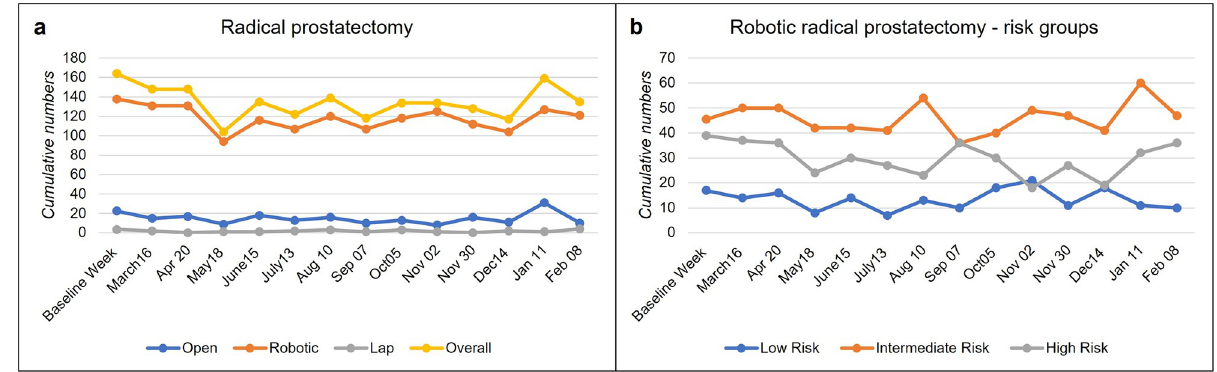
Fig 3. Changes in radical prostatectomies. (A) Overall numbers of radical prostatectomies classified as open, laparoscopic and robotic approaches and risk groups according to the D’Amico score (B).